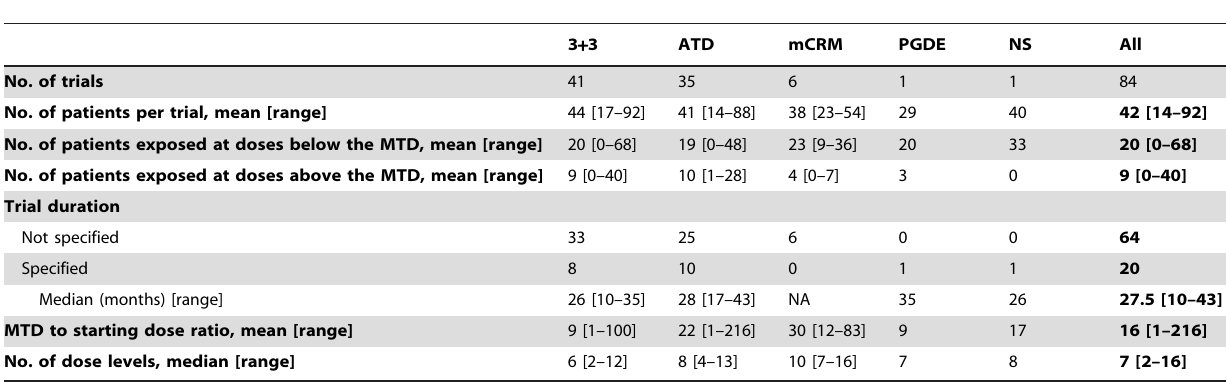
Table 1. Dose escalation efficiency parameters of first-in-human phase I trials of molecularly targeted agents according to the dose escalation method